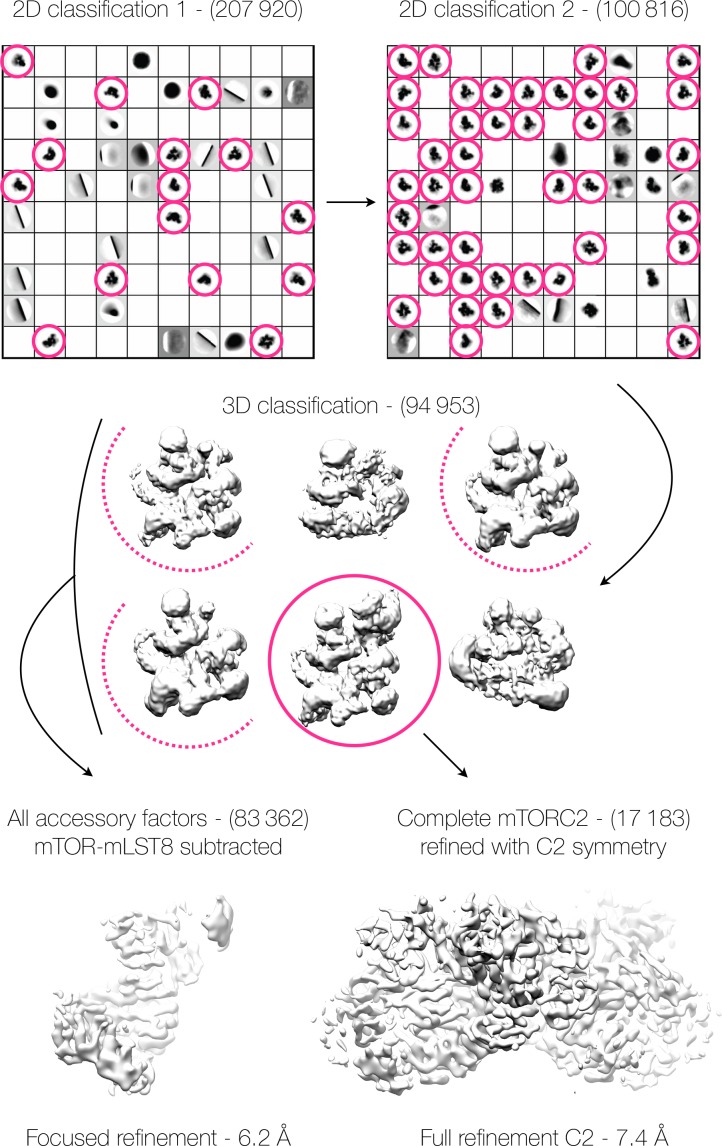
Cryo-EM classification schematic.The reconstructions from each round of classification, the number of particles involved in each step, and the retention of particles between stages of the classification are shown as a flow diagram. Magenta circles indicate the classes from which particles were retained at each stage, dotted half-circles indicate single-sided particles retained after subtraction of the opposing density.